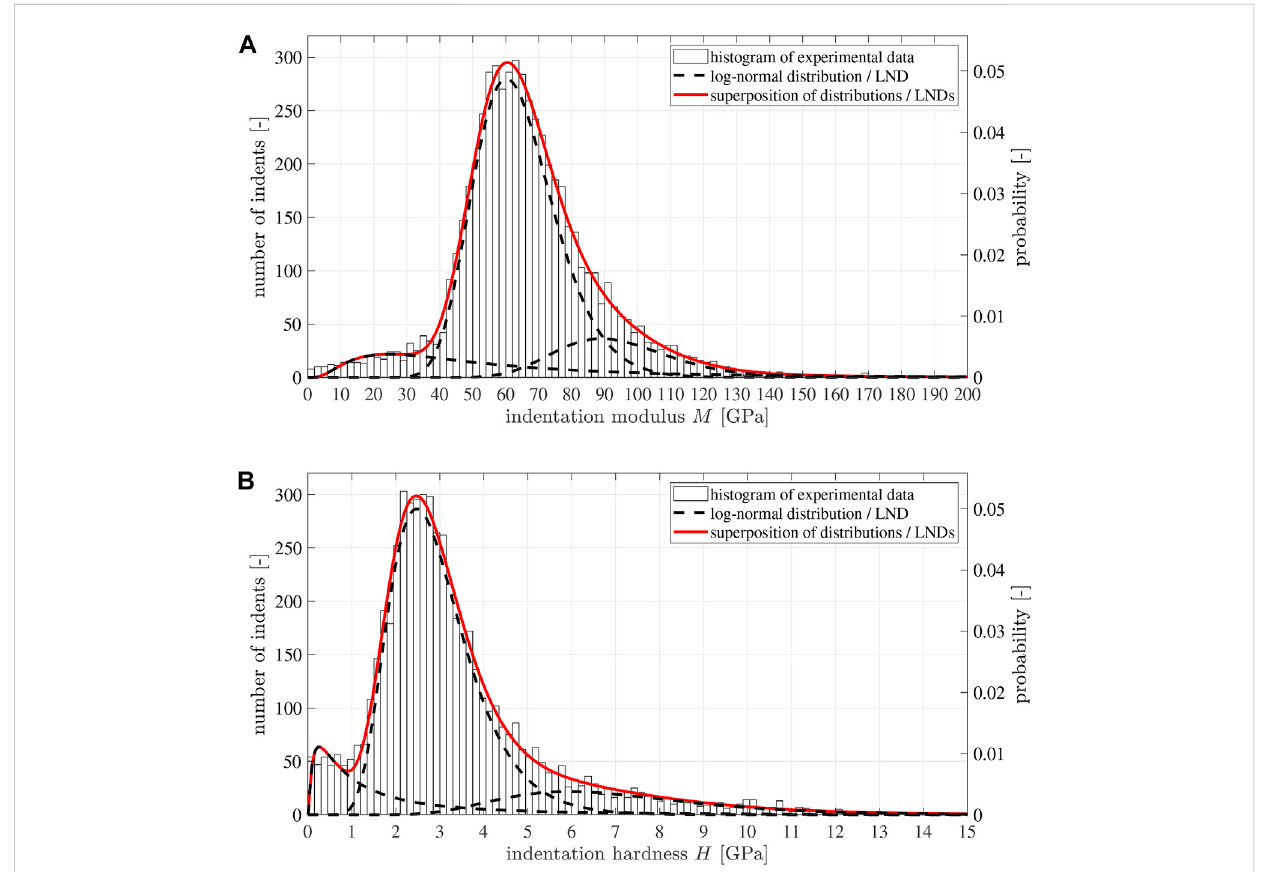
FIGURE 9 Histograms (A) of indentation modulus and (B) of the indentation hardness, approximated by means of the superposition of three lognormal distributions; after Dohnalík et al.